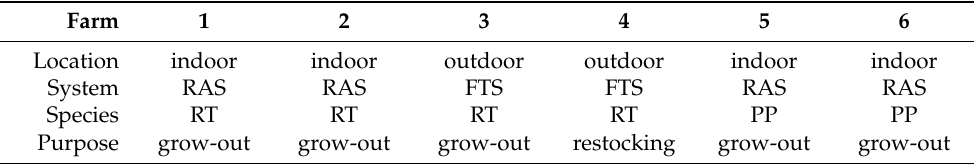
Table 2. Characteristics of the six fish farms for the model validation. RAS = recirculating aquaculture system, FTS = flow-through system, RT = rainbow trout, PP =